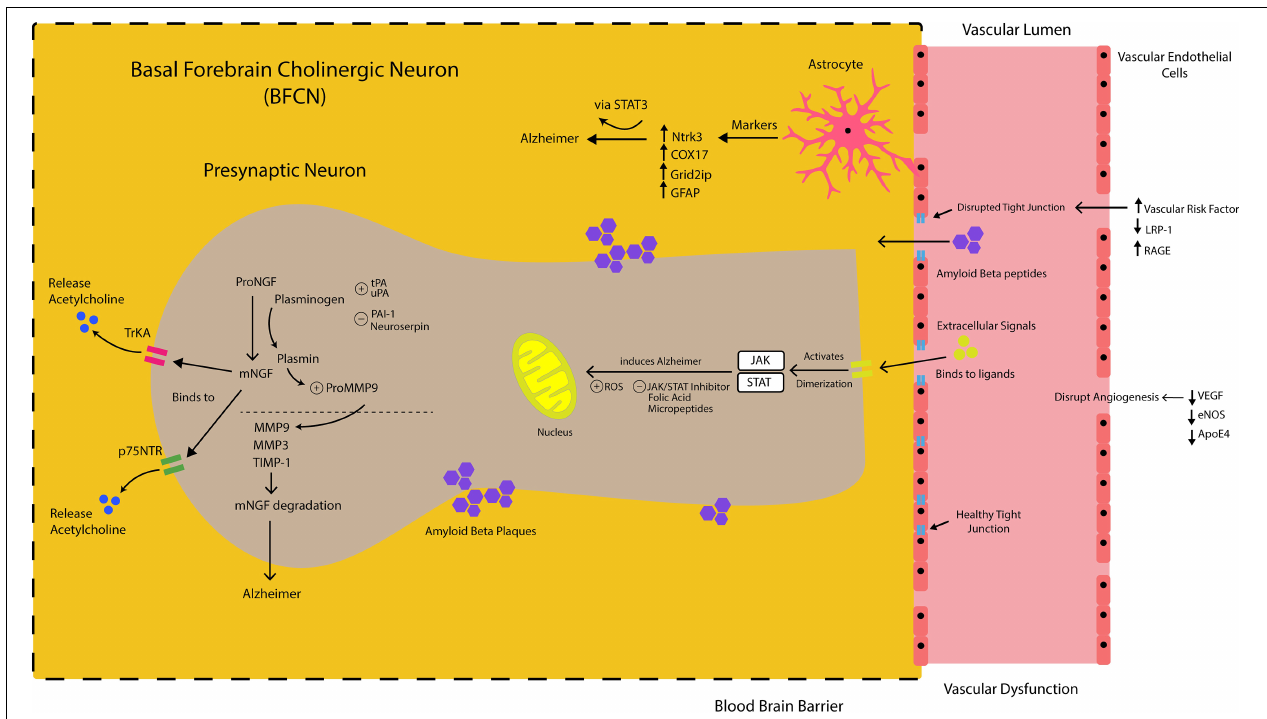
FIGURE 2 | Nerve growth factor (NGF) metabolic pathway in basal forebrain cholinergic neuron (BFCN) is mainly regulated by proteases involved in NGF maturation [tissue plasminogen activator (tPA), urokinase plasminogen activator (uPA), Plasminogen Activator Inhibitor 1 (PAI-1) and Neuroserpin)] and those involved in NGF degradation [matrix metalloproteinases (MMP9, MMP3) and tissue inhibitor of metalloproteinases 1 (TIMP-1)]. Plasmin is also responsible for proMMP-9 activation to MMP9. Extracellular signals (i.e., cytokines, hormones, and growth factor) bind to their ligands and activate Janus Kinase/ signal transducer and activator of transcription (JAK/STAT). This causes dimerization of the two and allows them to be translocated to the nucleus for transcriptional response. Reactive Oxygen Species (ROS) is involved in JAK/STAT-induced Alzheimer. JAK/STAT inhibitor, folic acid and micropeptides (i.e., humorin and colivelin) attenuate JAK/STAT-induced Alzheimer. Increased astrocytes biomarker Glial fibrillary acidic protein (GFAP) and Genes were predominantly expressed on Astrocytes- STAT3-induced Alzheimer’s disease (Neurotrophic Receptor Tyrosine Kinase 3 (ntrk3), Cytochrome C Oxidase Copper Chaperone ( COX17), and Grid2 Interacting Protein (Grid2ip). Decreased vascular endothelial growth factor (VEGF), endothelial nitric oxide synthase (eNOS) and apolipoprotein e4 (ApoE4) disrupt normal angiogenesis. Increased vascular risk factor, receptor for advanced glycation end products (RAGE) and reduced LDL-receptor related protein-1 (LRP-1) disrupt healthy tight junction. Disruption of normal angiogenesis and healthy tight junction allow Amyloid-Beta peptides efflux from vessels to brain parenchyma and promoting Amyloid-Beta plaques